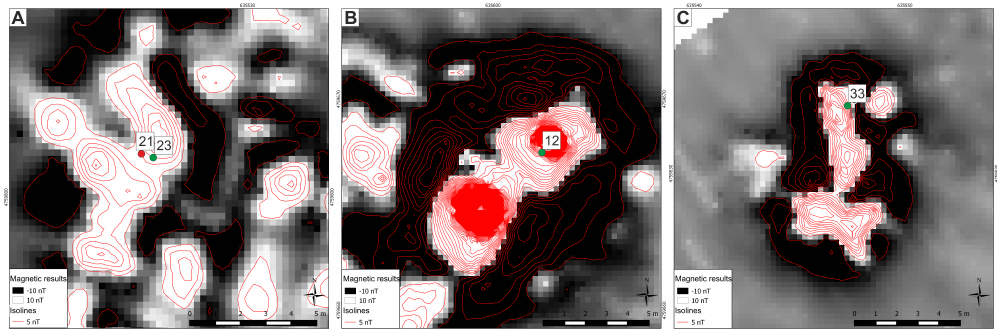
Figure 9. ( A ) Location of the sediment core 23 over the magnetic response map; ( B ) Location of the sediment core 12 over the magnetic response map; ( C ) Location of the sediment core 33 over the magnetic response map. The magnetic contrast is the same in all the figures ( − 10 nT black, 10 nT white). The areas are highlighted in the general context of Figure 6.